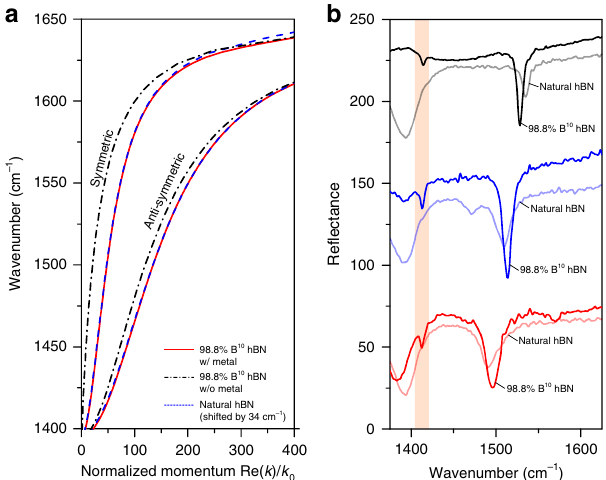
Fig. 4 Naturally abundant hBN vs. 10 B-enriched h 10 BN. a The dispersion of hyperbolic image polaritons for the naturally abundant (blue dashed line) and isotopically enriched h 10 BN (red solid lines) for the gap size of 3 nm. The black alternating lines represent the dispersions of normal HPhPs without a mirror in isotopically enriched hBN. b The measured re fl ection spectra for the two hBN for different gap sizes of 3, 8, and 20 nm given the periodicity of 150 nm. In all cases, the spectra from naturally abundant hBN cases are shifted toward higher frequencies by 34 cm − 1 to align the Reststrahlen bands for better visibility. The orange shaded region shows the presence of the resonances from the anti-symmetric modes, which can be observed only in the h 10 BN